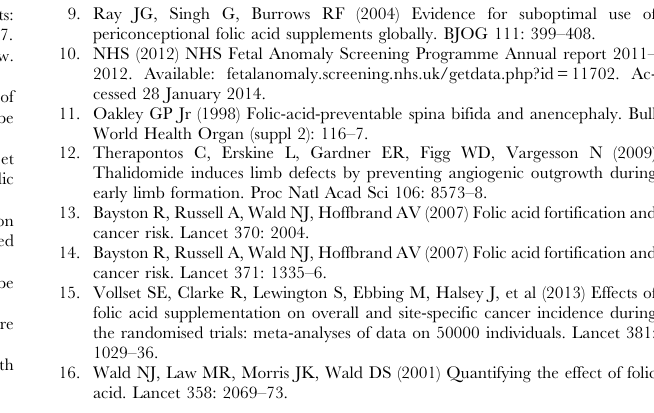
Table S1 Percentage of women taking folic acid before pregnancy, once pregnancy confirmed or not at all